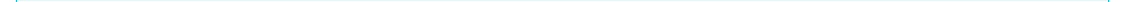
Figure 2: Case illustration 1 (single fraction radiosurgery 24 Gy at the 50% isodose line; images a1 and a2): 50-year-old patient with a right temporal AVM, Spetzler-Martin grade II, fed by temporal branches of the inferior sylvian trunk, with both superficial and deep venous drainage; clinical discovery after initial seizure; (a1) initial DSA, and (a2) DSA 3 years after treatment, showing complete obliteration; clinically, disap- pearance of seizures.Case illustration 2 (“staged-volume” radiosurgery, 20 Gy at the 50% isodose line, at 9 months interval; images b1 and b2): 52-year-old patient, presenting with large right temporo-insular AVM, Spetzler-Martin grade III, fed both by the middle and posterior cere- bral arteries, with an important afferent component by the anterior choroid artery, with both superficial and deep venous drainage; clinical dis- covery after initial seizure; (b1) initial DSA, and (b2) DSA 2 years after treatment, showing complete obliteration; clinically, disappearance of